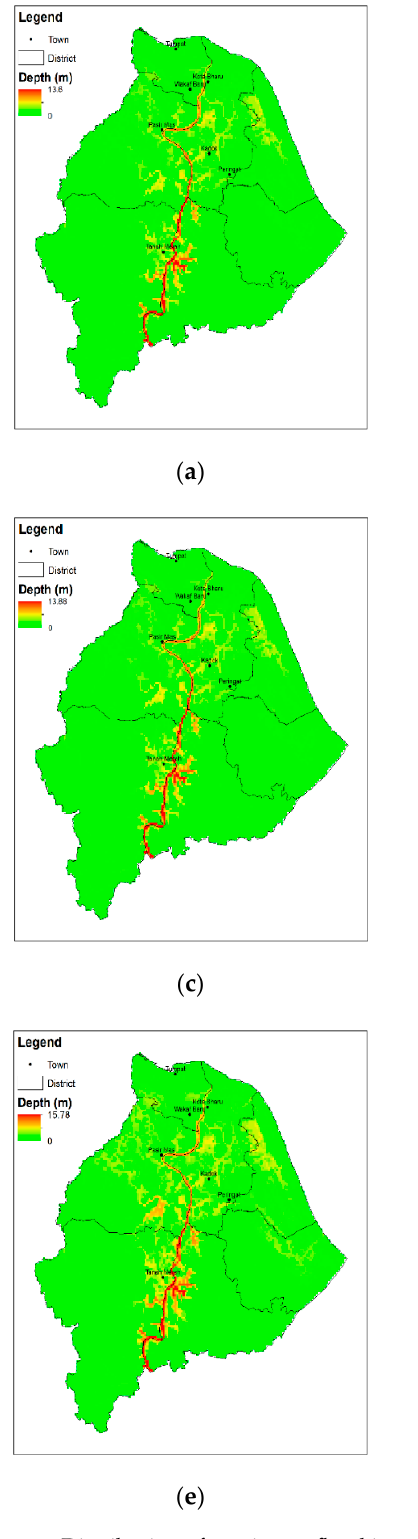
Figure 7. Distribution of maximum flood inundation depth at downstream from 15 December 2014 to 1 January 2015, calculated by the calibrated Rainfall-Runoff-Inundation (RRI) model; ( a ) Precipitation Estimation from Remotely Sensed Information using Artificial Neural Networks- Cloud Classification System (PERSIANN-CCS) ( b ) Integrated Multi-satellitE Retrievals-Late (IMERG-L) ( c ) Integrated Multi-satellitE Retrievals-Early (IMERG-E) ( d ) Global Satellite Mapping of Precipitation GSMaP ( e ) Gauge.